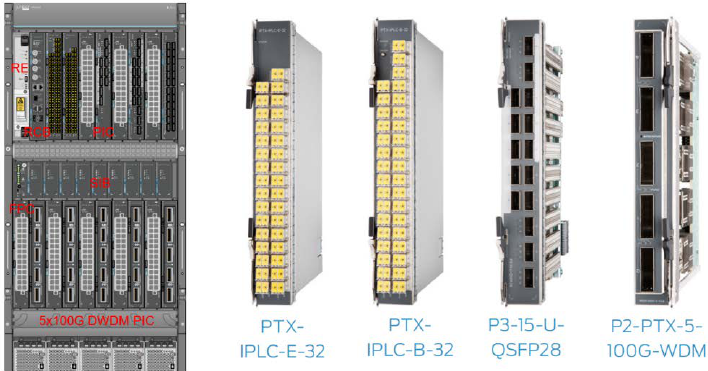
Figure 1. Typical architecture of core router and Juniper packet optical product. RE: routing engine; RCB: routing control board; PIC: physical interface card; FPC: Flexible PIC concentrator; SIB: switch interface board.